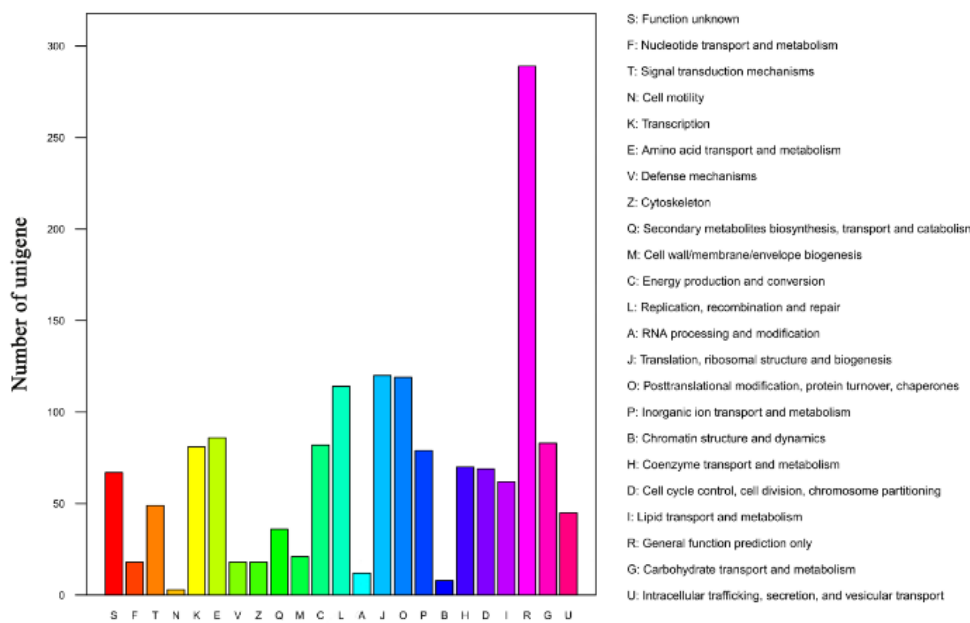
Figure 2. Functional annotations of the unigenes of Mortierella alpina based on the Cluster of Ortholo- gous Groups (COG)